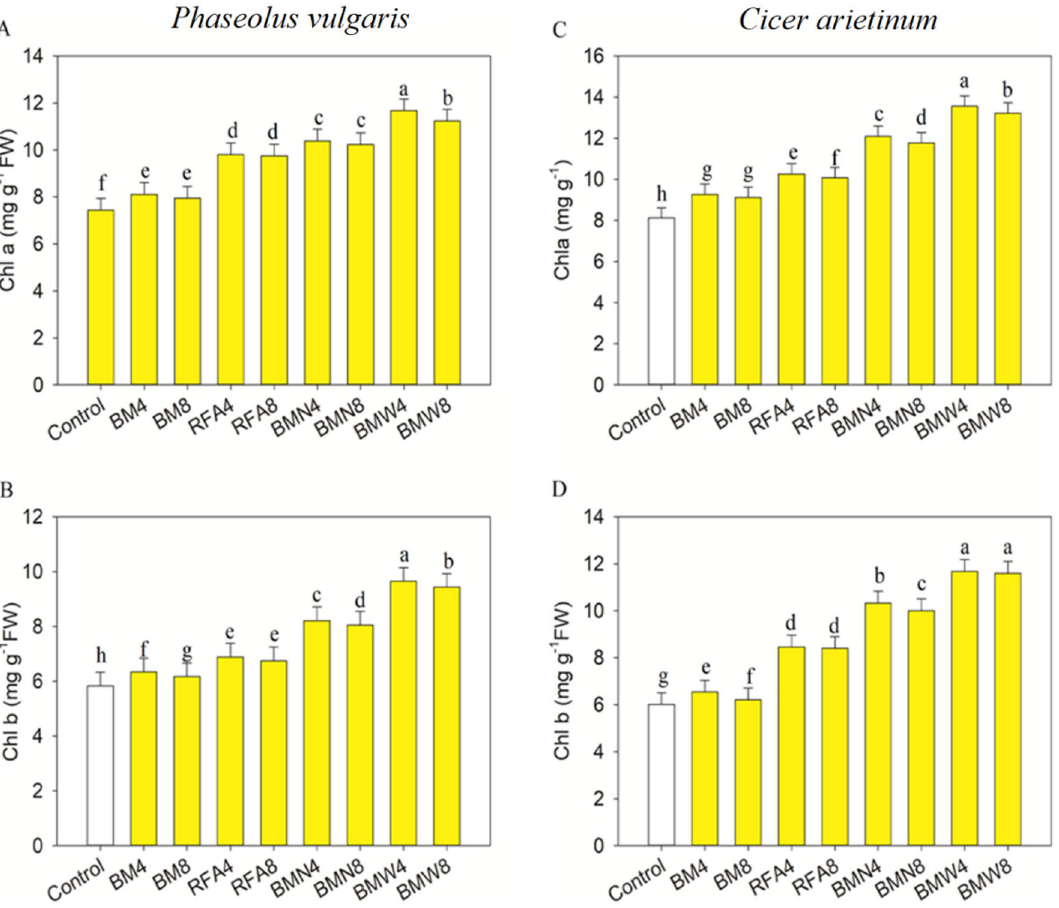
Figure 4. Impact of CNP treatment on the Chl a and Chl b contents of Phaseolus vulgaris ( A,B ) and Cicer arietinum ( C,D ) seedlings. The bars represent standard deviations (SD) for three replicates, and the different letters denote the treatment differences that are statistically